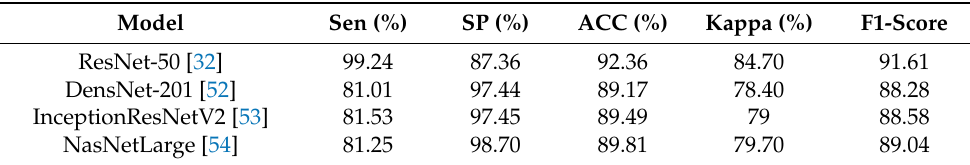
Table 4. The performance comparison on the CBIS-DDSM dataset using different convolutional neural networks (CNN).